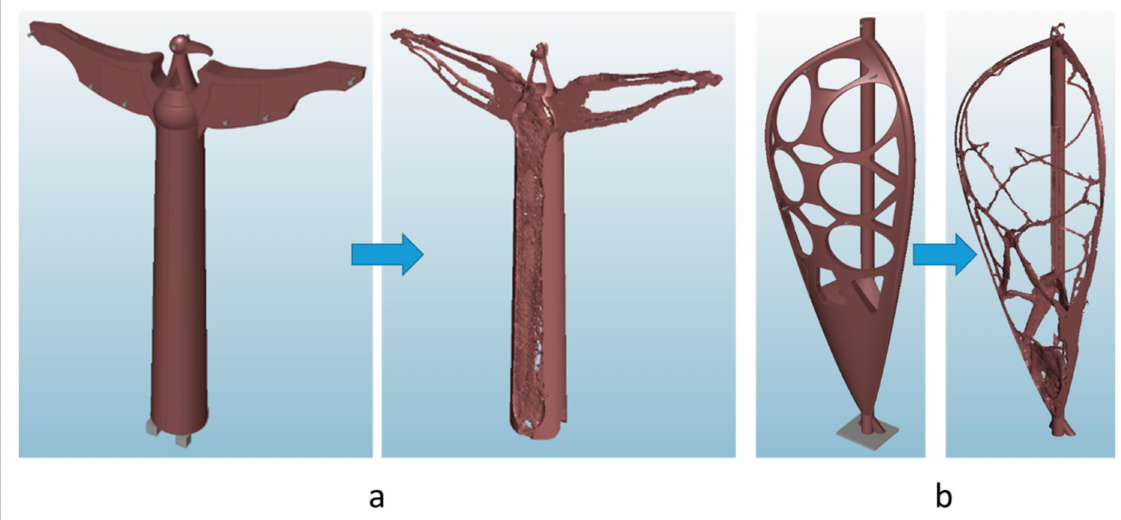
Figure 13. Updated 3D models and topology optimization results: final weight reduction. ( a ) Eagle ( b )